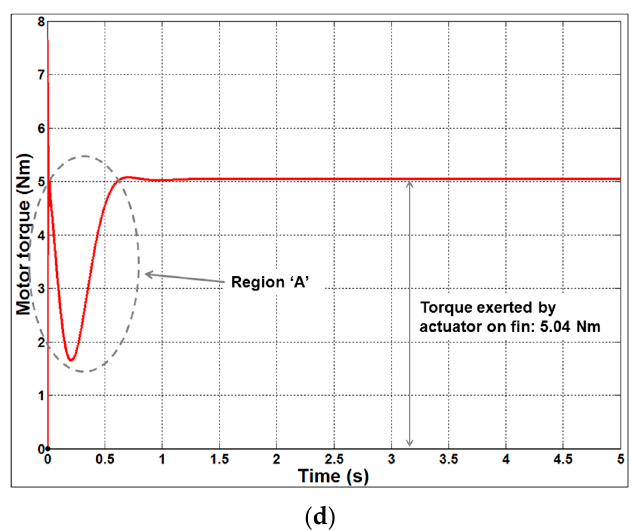
Figure 11. The 10 g step input response of the autopilot. ( a ) Speed characteristics of the actuator for a step input of 10 g; ( b ) Autopilot LATAX with respect to missile fin angle for a step input of 10 g; ( c ) LATAX response of the autopilot for a step input of 10 g; ( d ) Torque exerted by the actuator on the missile fin for a step input of 10 g.